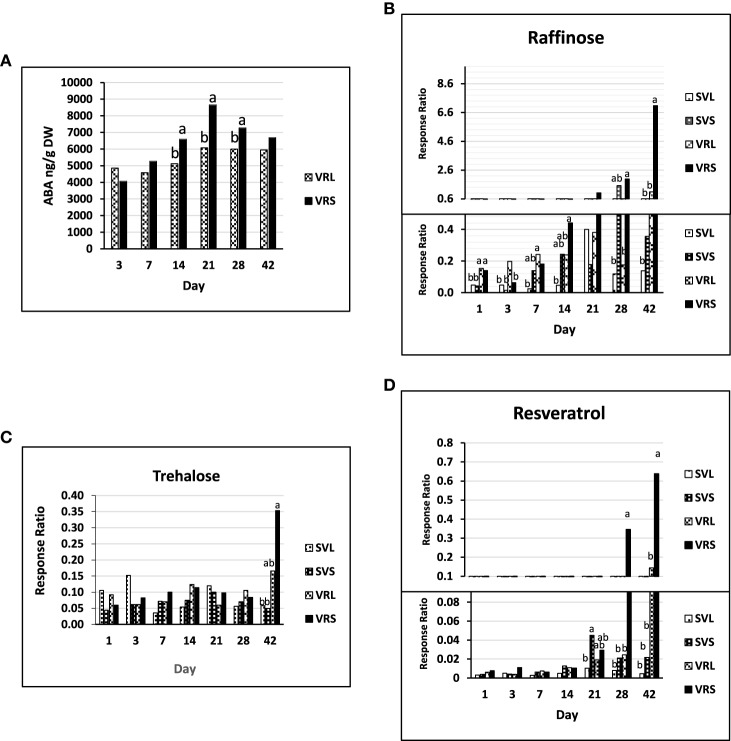
Metabolites in V. riparia and Seyval under long or short day conditions (VRL or VRS and SVL or SVS). (A) Abscisic acid concentration in V. riparia long or short day buds (VRL or VRS, respectively). Values are ABA concentration per gram dry weight (DW) (B) Raffinose accumulation relative to ribitol in V. riparia and Seyval long or short day buds (VRL, VRS, SVL, SVS; respectively). (C) Trehalose accumulation relative to ribitol (response ratio) in VRL, VRS, SVL and SVS. (D) Resveratrol accumulation relative to ribitol (response ratio) in VRL, VRS, SVL, and SVS. Values are mean and standard error of abundance. Tukey's HSD significant differences (p < 0.05, n = 5) between SVL, SVS, VRL, and VRS at a given time point are noted by different letters, no letter indicates no difference found at that time point.